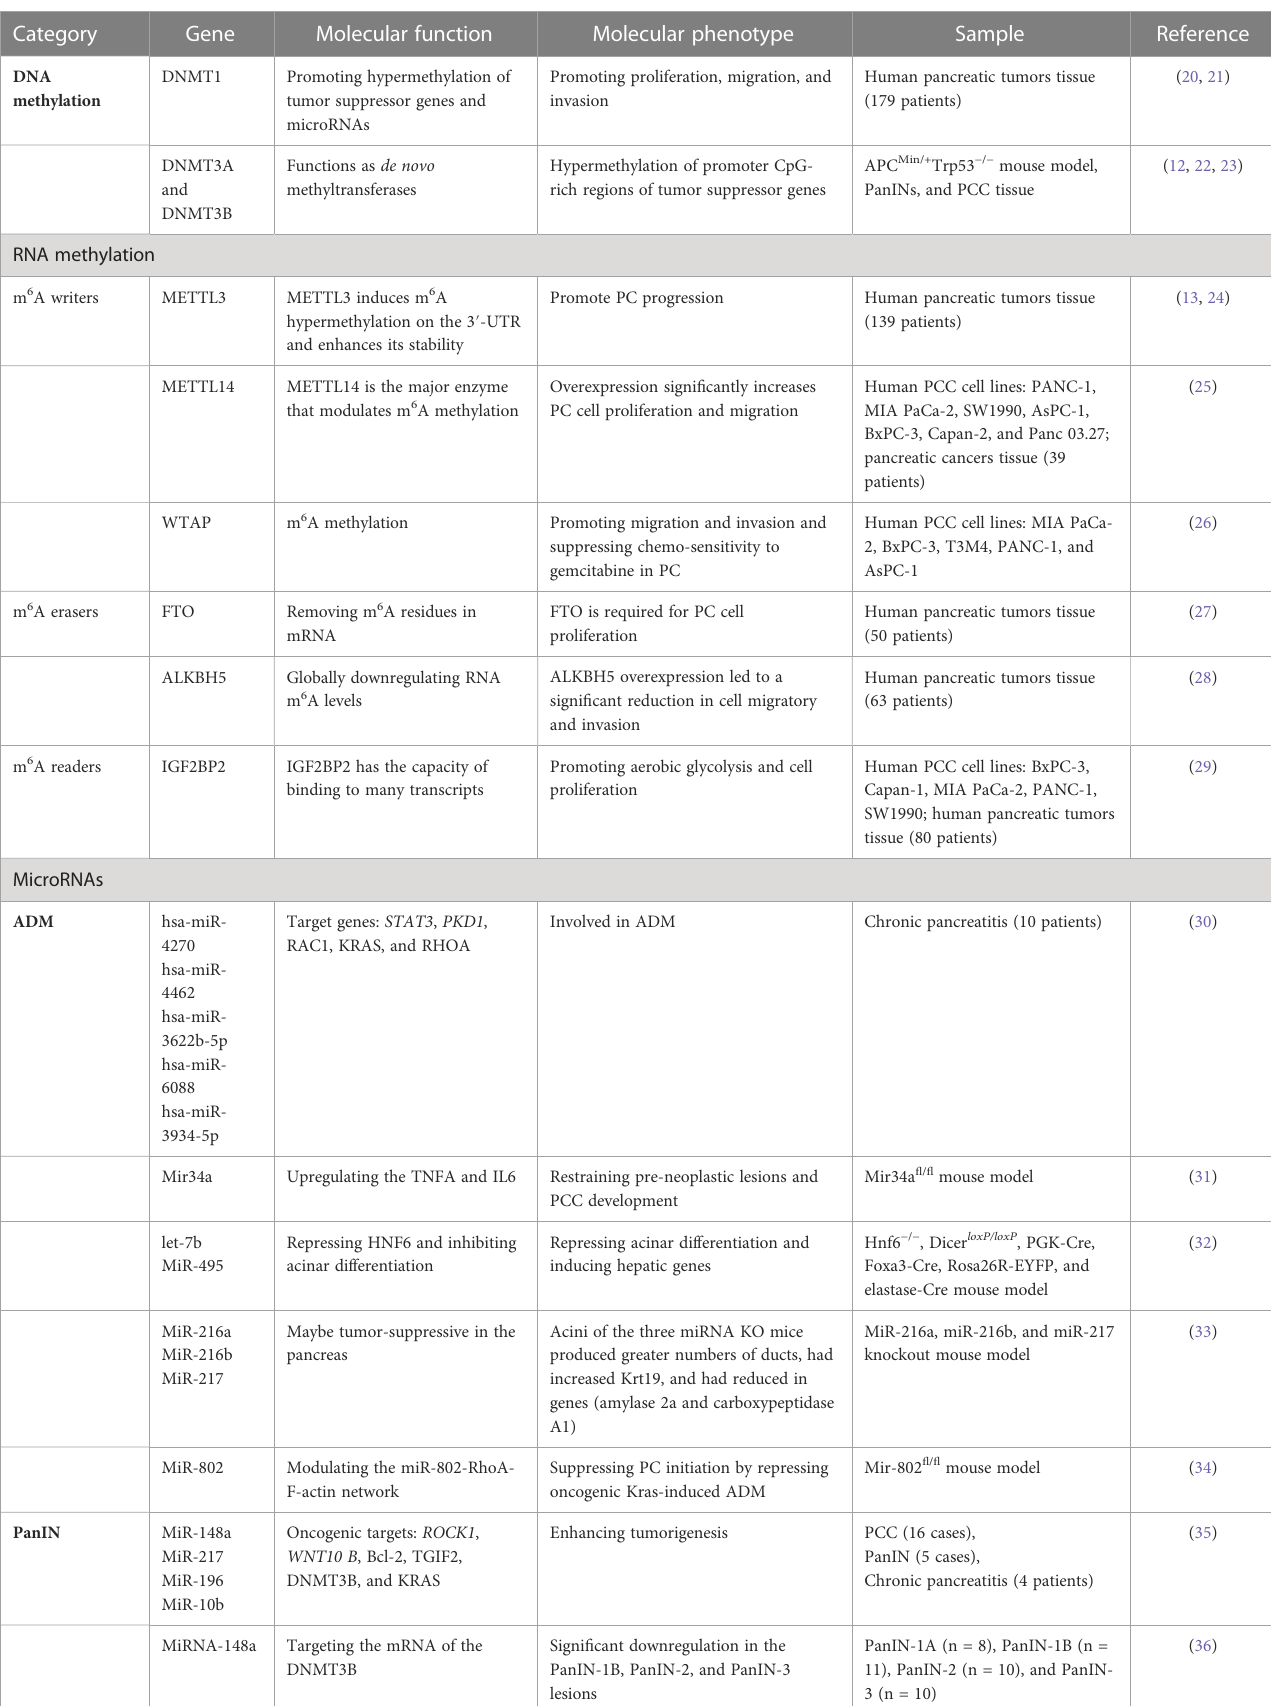
TABLE 1 Epigenetic alterations in premalignant and malignant pancreatic cancer.